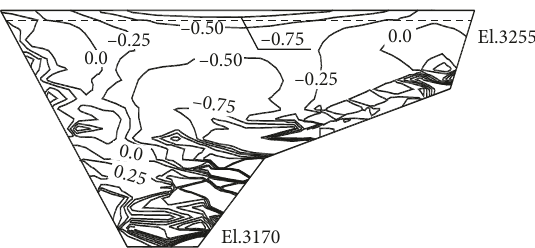
Figure 17: Shear stress in the concrete face under condition 3 with the water level at 3255m (units: MPa).